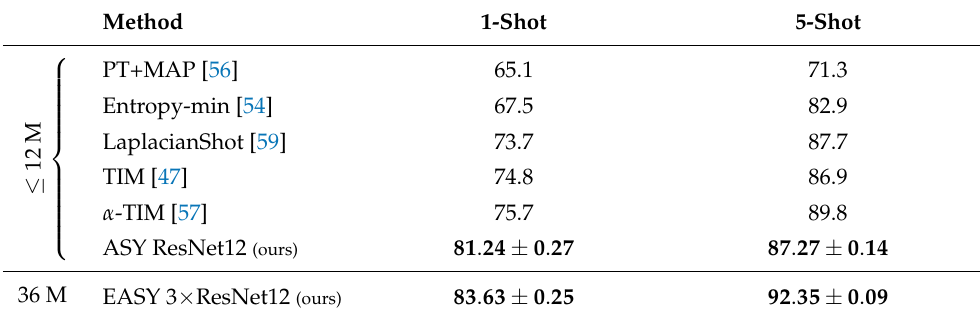
Table A3. The 1-shot and 5-shot accuracy of state-of-the-art methods and the proposed solution on CUB-FS in the imbalanced transductive